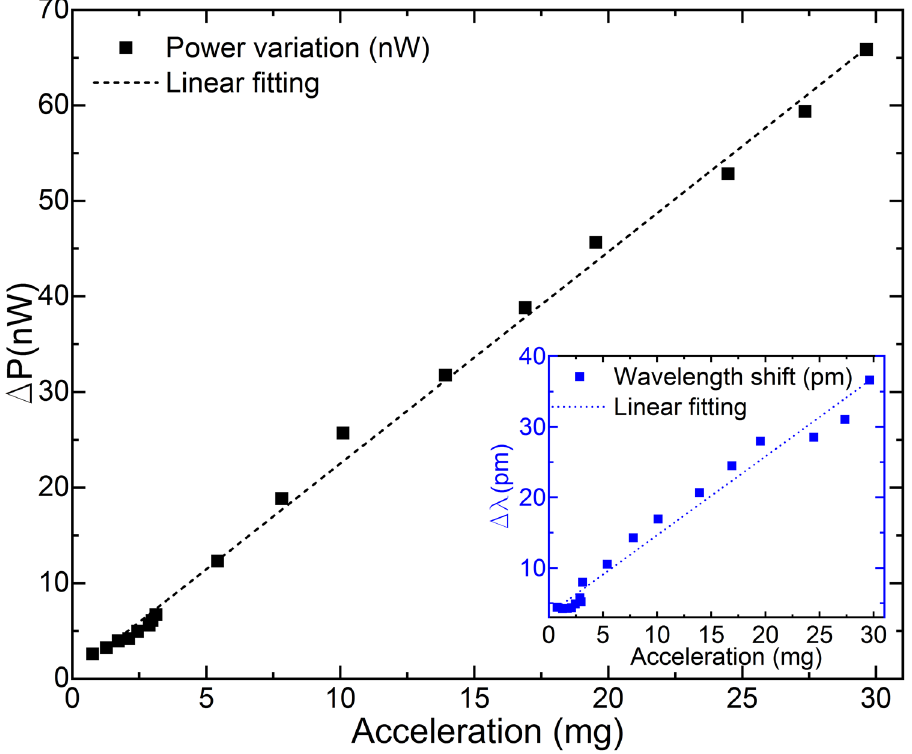
Figure 12. Calibration of the manufactured optical accelerometer in terms of power variation. The calibration of the device in terms of wavelength shift is shown in the